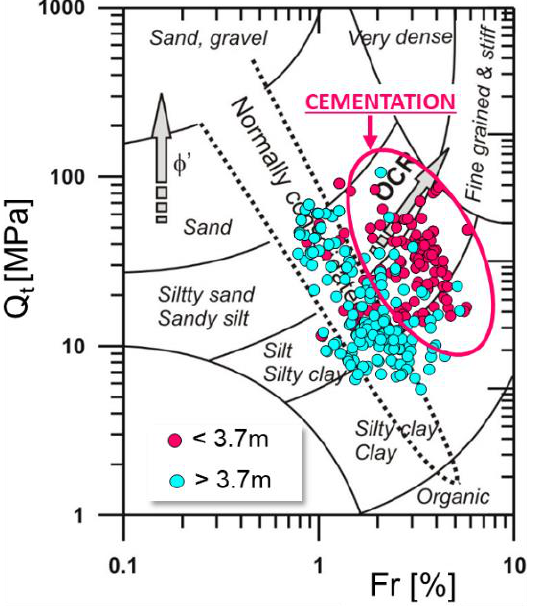
Figure 6. Location of soil from area A on a Robertson diagram [65].